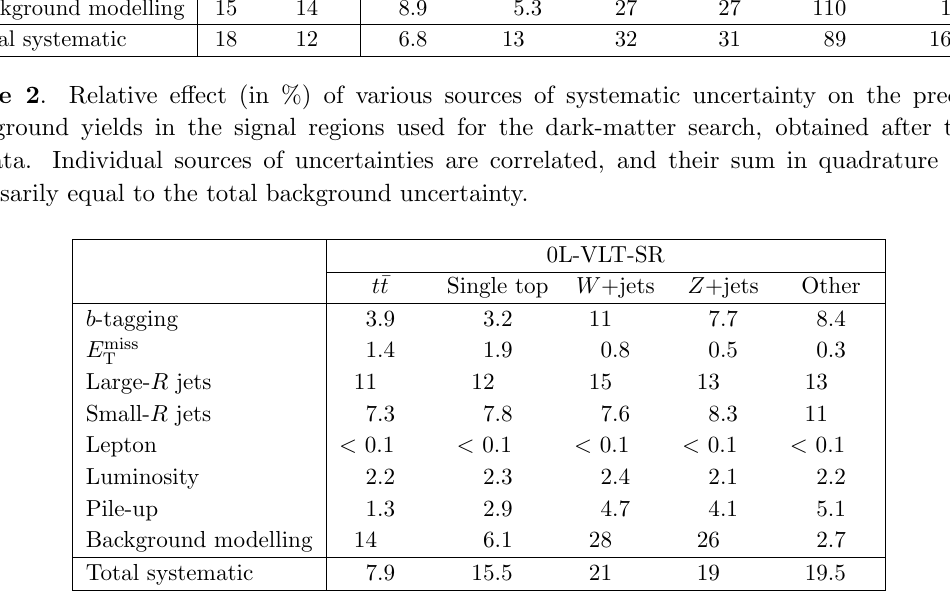
Table 3 . Relative e(cid:11)ect (in %) of various sources of systematic uncertainty on the predicted background yields in the signal region used for the vector-like T -quark search, obtained after the (cid:12)t to data. Individual sources of uncertainties are correlated, and their sum in quadrature is not necessarily equal to the total background